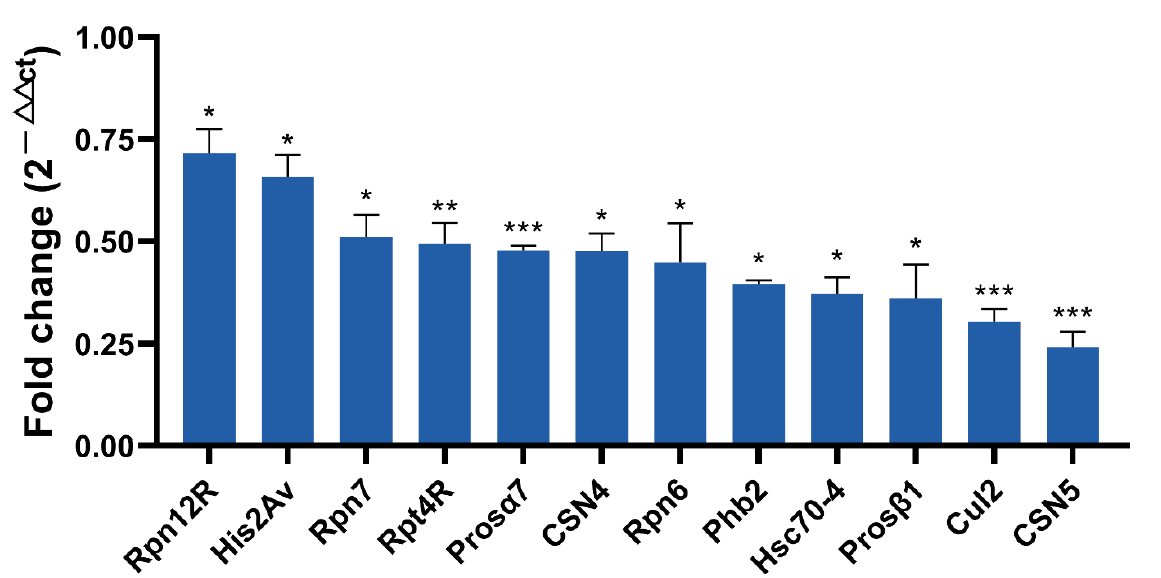
Figure 7. qRT-PCR validation of selected differentially expressed protein coding genes identified by proteomic and ubiquitome analyses. * p < 0.05; ** p < 0.01; *** p < 0.001.